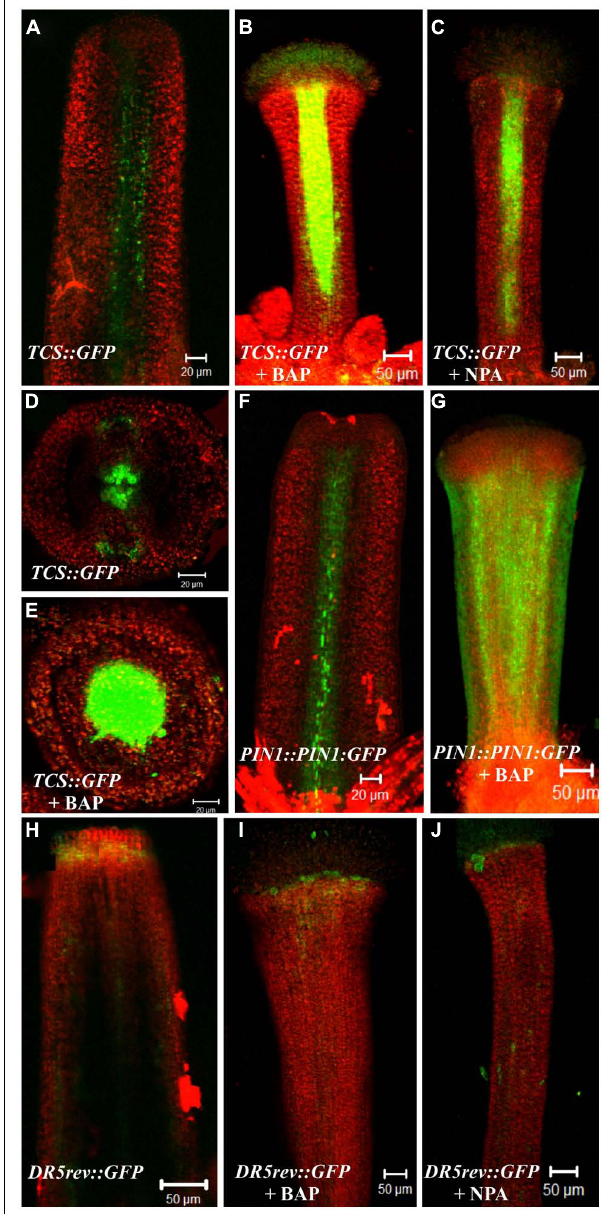
FIGURE 4 | Effect of cytokinin (BAP) and NPA application on the PIN1 ( PIN1::PIN1:GFP ), cytokinin ( TCS::GFP ) and the auxin-response markers ( DR5::GFP ). (A–E) The fluorescence signal of the cytokinin response marker TCS::GFP observed in the wild type gynoecium at floral stage 10 in a longitudinal view (A) and transverse view (D) .Valveless gynoecium at floral stage 11 caused by BAP treatment in a longitudinal view (B) and transverse view (E) .Valveless gynoecium at floral stage 11 caused by NPA treatment in a longitudinal view (C) . (F,G) The fluorescence signal detection of the PIN1 marker PIN1::PIN1:GFP observed in the wild type gynoecium at floral stage 10 (F) .Valveless gynoecium at floral stage 10 caused by BAP treatment (G) . (H–J) The fluorescence signal detection of the auxin response marker DR5::GFP observed in wild type gynoecium at stage 12 (H) .Valveless gynoecium at floral stage 12 caused by BAP treatment (I) .Valveless gynoecium at floral stage 12 caused by NPA treatment (J) . Scale bars: (A,D–F) 20 μ m; (B,C,G–J) 50 μ